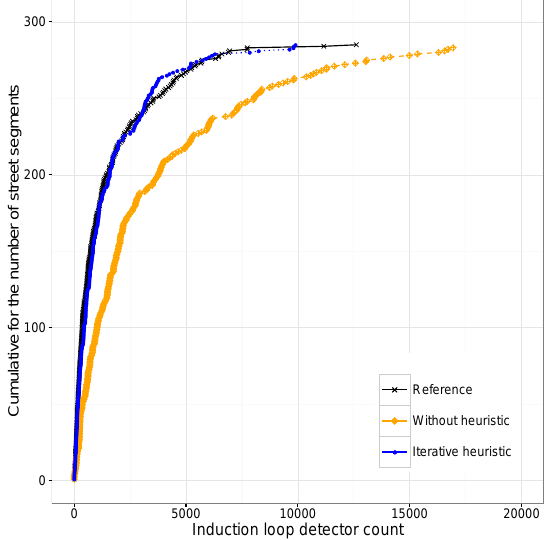
Figure 1. Traffic flow modeling for Valencia. Results with and without our iterative heuristic